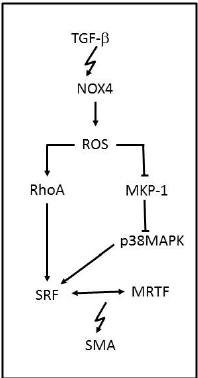
Figure 3. NADPH oxidase ‐ modulated pathway in vascular smooth muscle cell differentiation. The